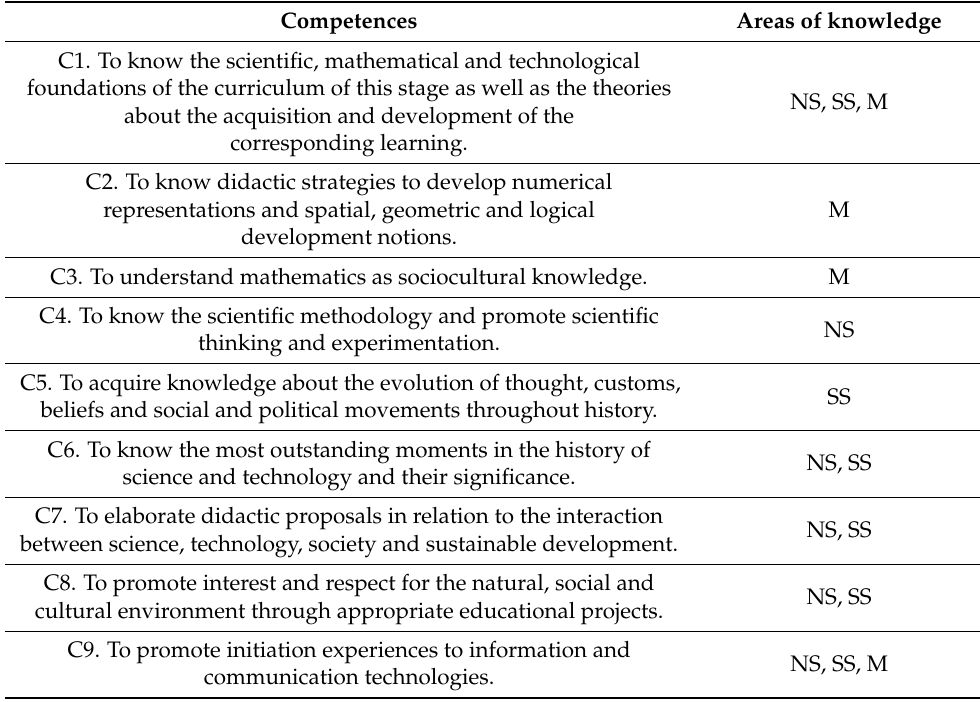
Table 1. Competences of the didactic and disciplinary module “Learning Natural Sciences, Social Sciences and